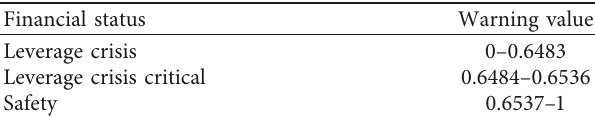
Table 4: Standards for judgment of financial leverage